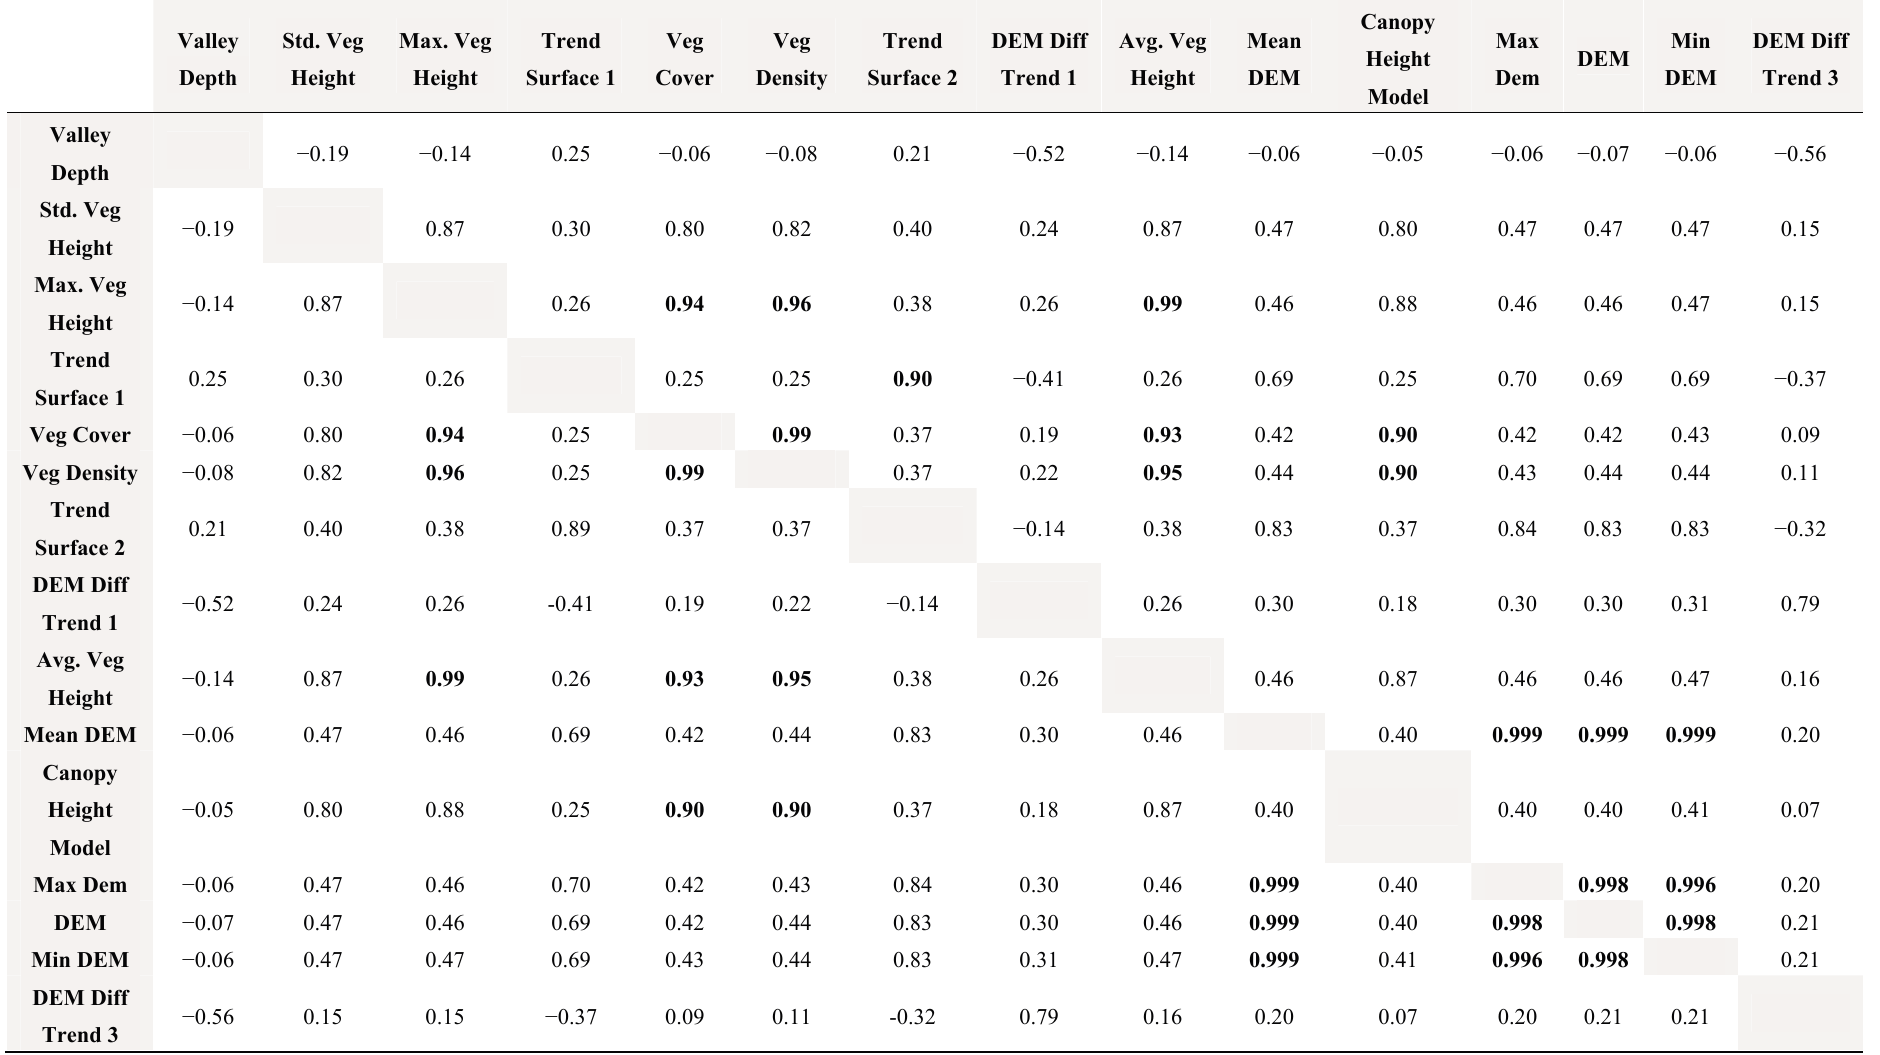
Table 3. Most important variables selected by randomForest, and pairwise